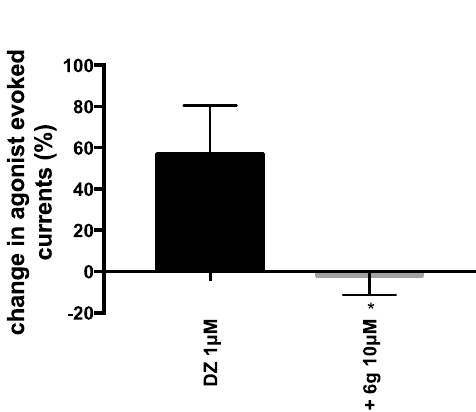
Figure 3. Compound 6g antagonized the potentiation of GABA-induced Cl − currents by diazepam in Xenopus oocytes expressing recombinant α 1 β 2 γ 2L GABA A receptors. Data are expressed as the percentage potentiation of the response induced by GABA at EC 5–10 values, and are the mean ± SEM of values obtained from four oocytes. p < 0.05 Mann–Whitney test.